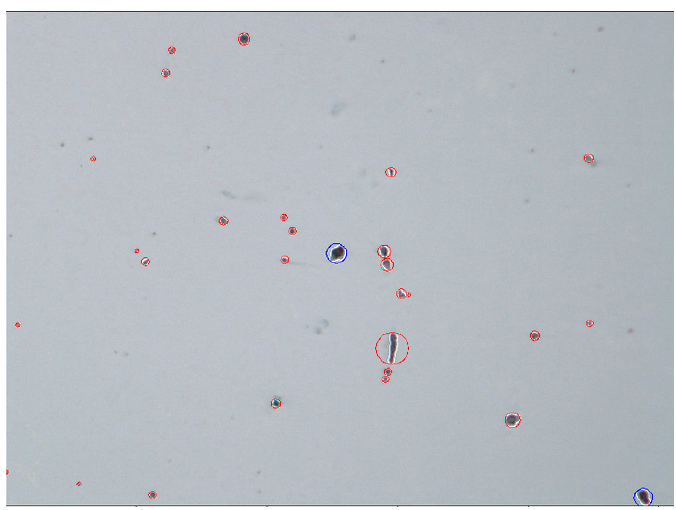
Figure 3. View of the macrostructure of 18CrNiMo7-6 steel with the types of inclusions marked: red colour—oxides, blue colour—sulphides (total dimension of the analysis area 20 mm 2 ; magnitude 200×).